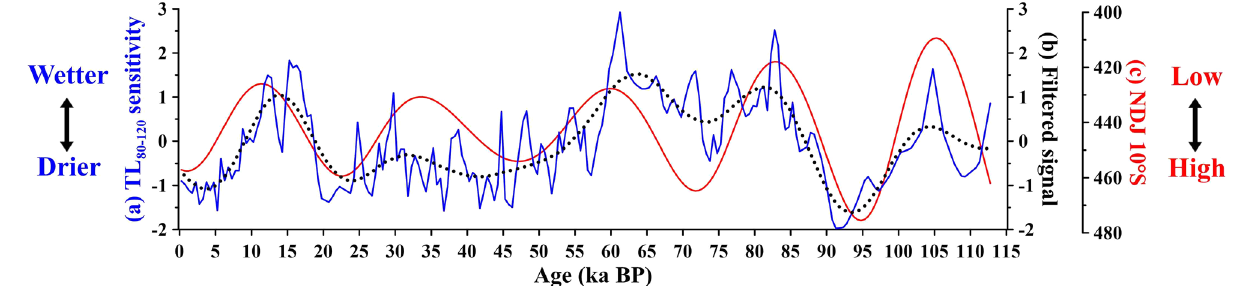
Figure 2. New northern NE Brazil (NEB) precipitation record. ( a ) Thermoluminescence (TL 80–120 ) sensitivity of the 110 °C peak from marine sediment cores GL-1248 (0.92°S, 43.40°W) and GeoB16206-1 (1.58°S, 43.02°W) 21 (details regarding merging these records are available in Text S1 and Fig. S1). ( b ) TL sensitivity record filtered in 0.026 ka frequency (19 ka, FIR filter) within software PAST v4.03 46 . ( c ) November–January (NDJ) insolation (W/m 2 ) at 10°S 47